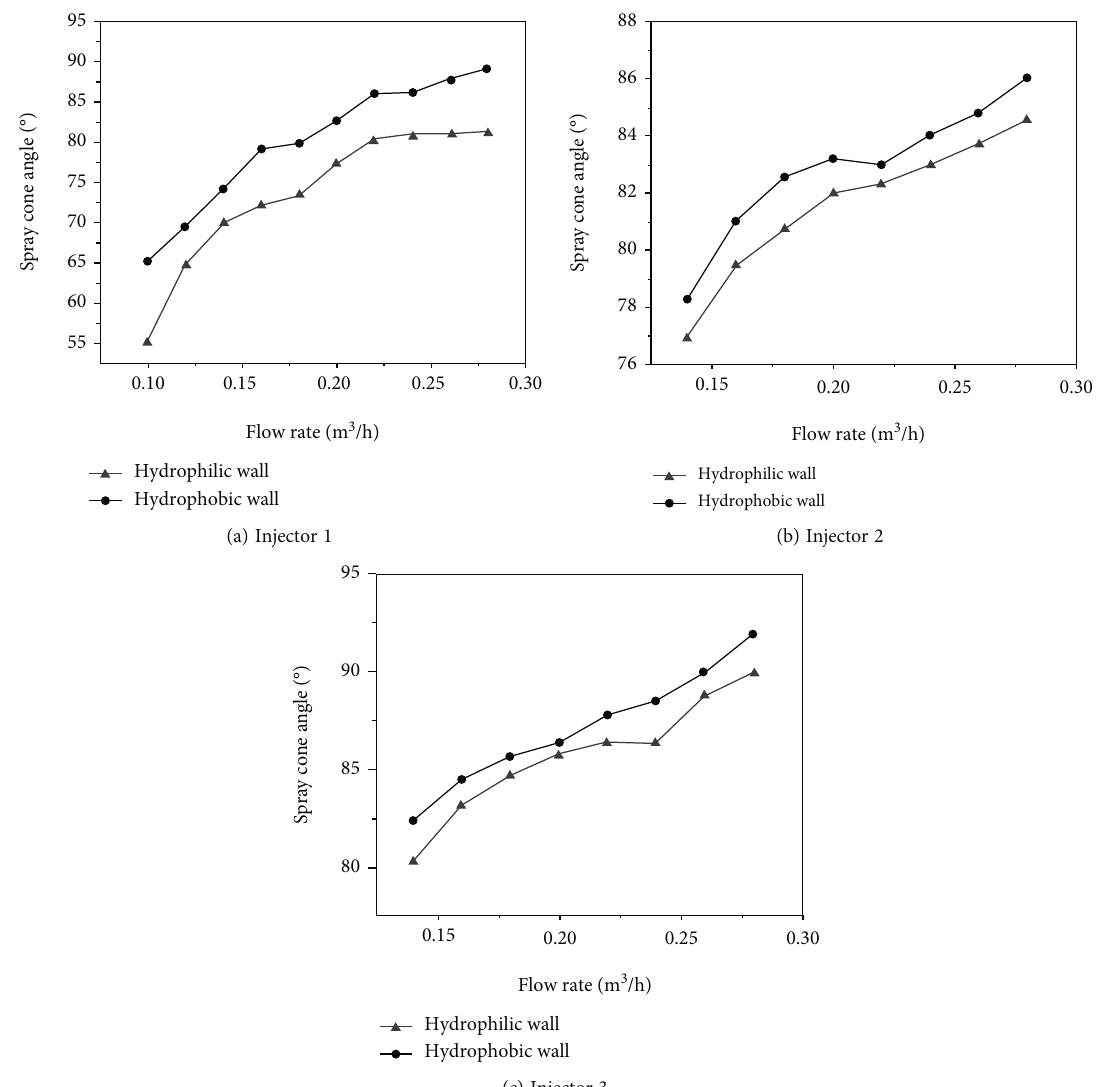
Figure 5: E ff ect of the fl ow rate on the injector spray cone angle in di ff erent